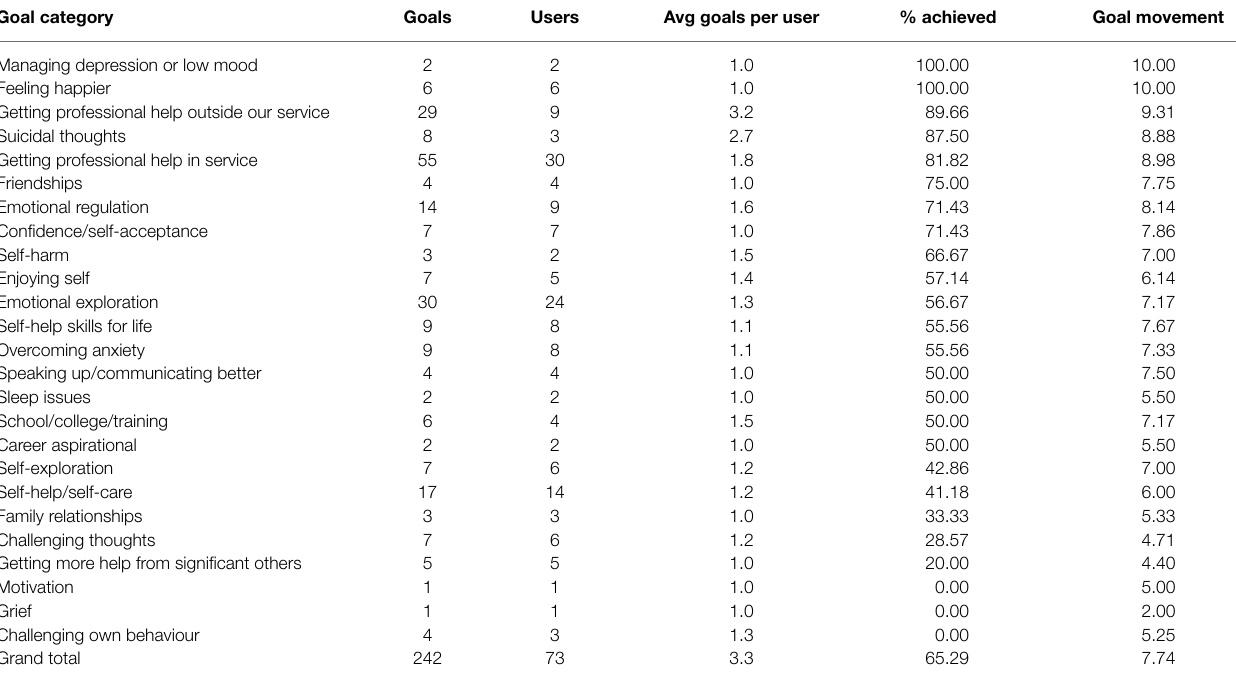
TABLE 1 | Summary of the types of goals articulated and average movement of these goals during therapy. Goal